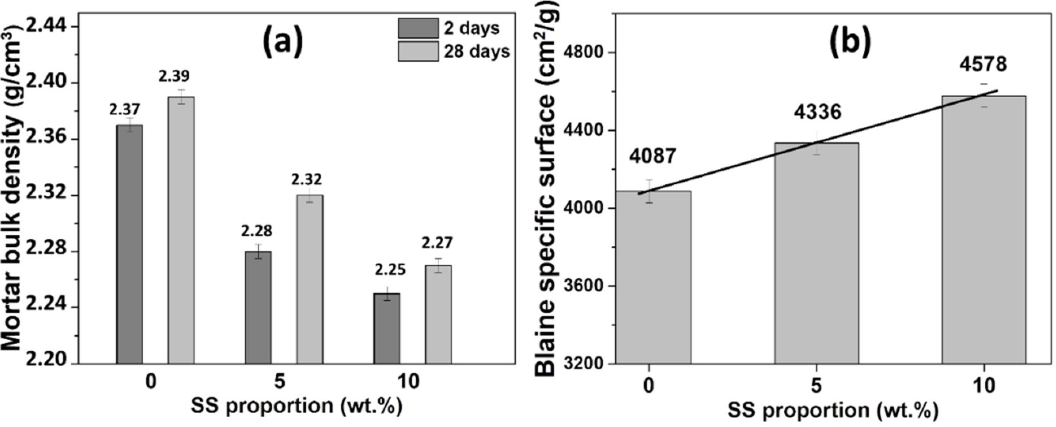
Figure 8. Evolution of: ( a ) the density and ( b ) Blaine specific surface area (SSA) of the cements elaborated with different proportions of SS.